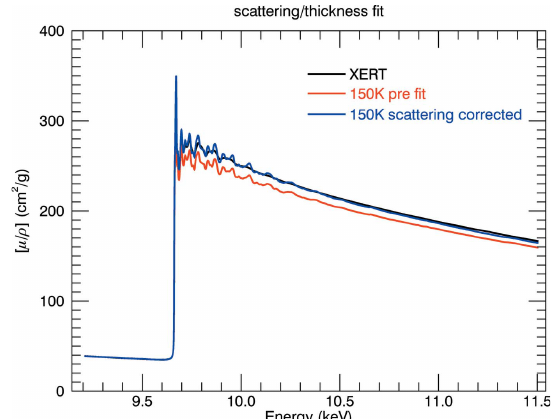
Figure 27 Effect of correcting for the scattering according to equation (13). The model is effective across the whole energy range. ‘XERT’ is the reference data taken at 298 K (Ekanayake et al. , 2021 a , b ; Sier et al. , 2022). ‘150 K’ is this work, for T = 150 K